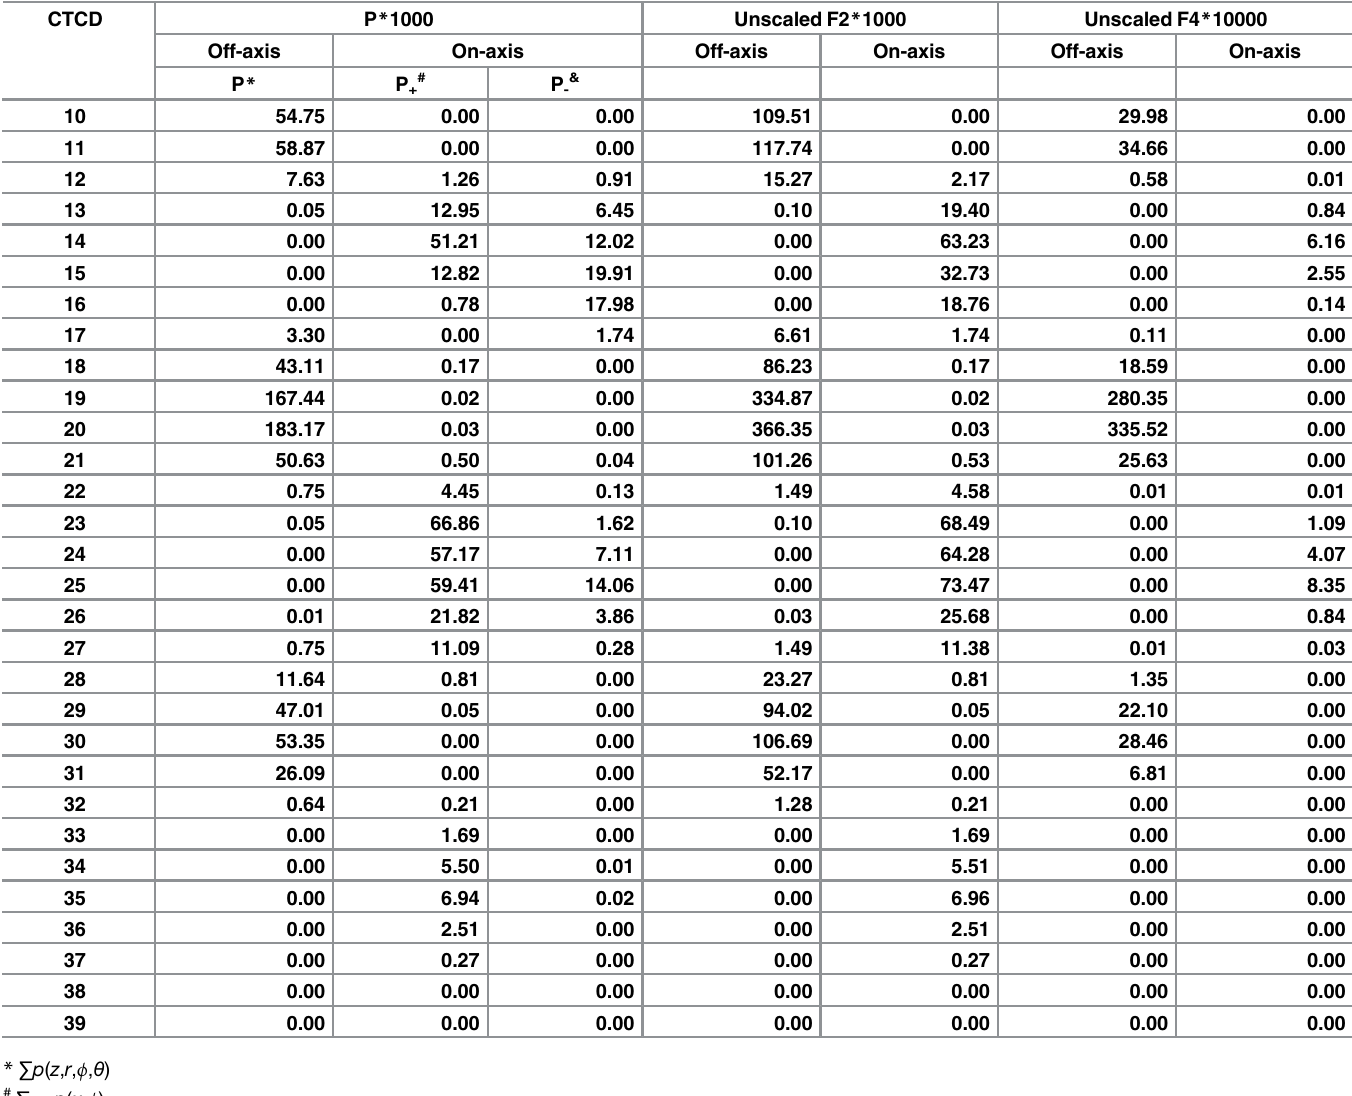
Table 4. Computed probability sums and raw feasibility measures using 10.0 bps/turn